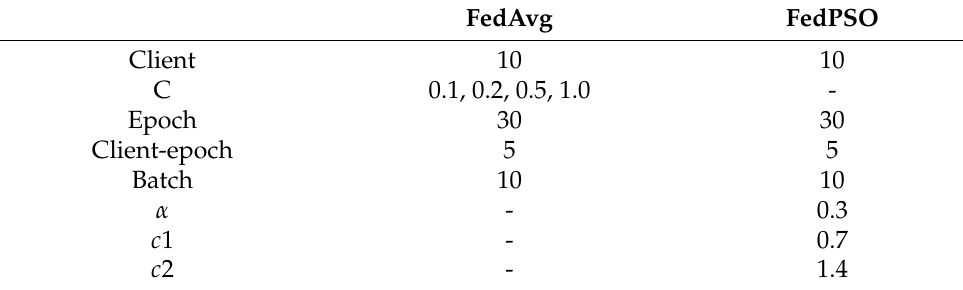
Table 2. The constant of our proposed